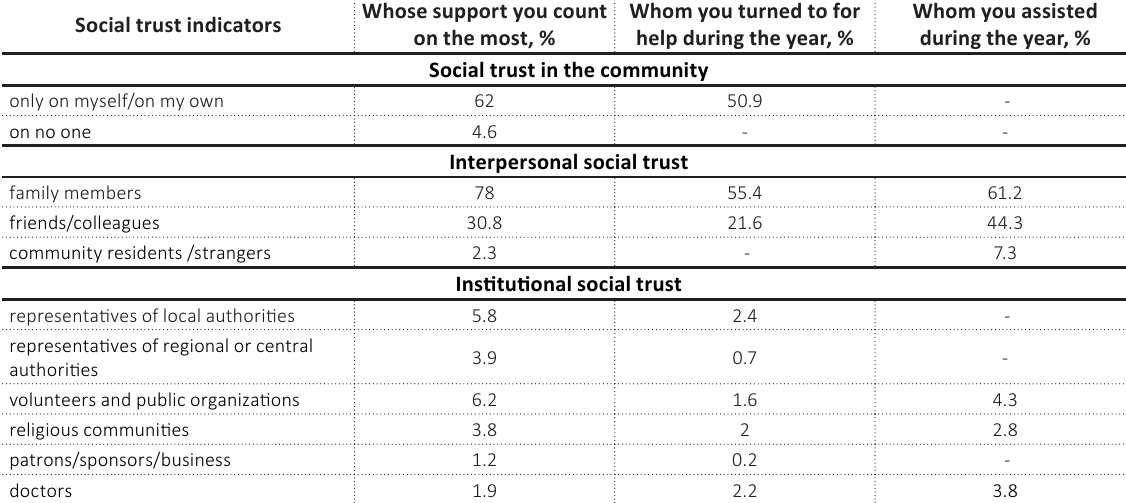
Table 1. Indicators of interpersonal and institutional social trust in selected territorial communities Social trust